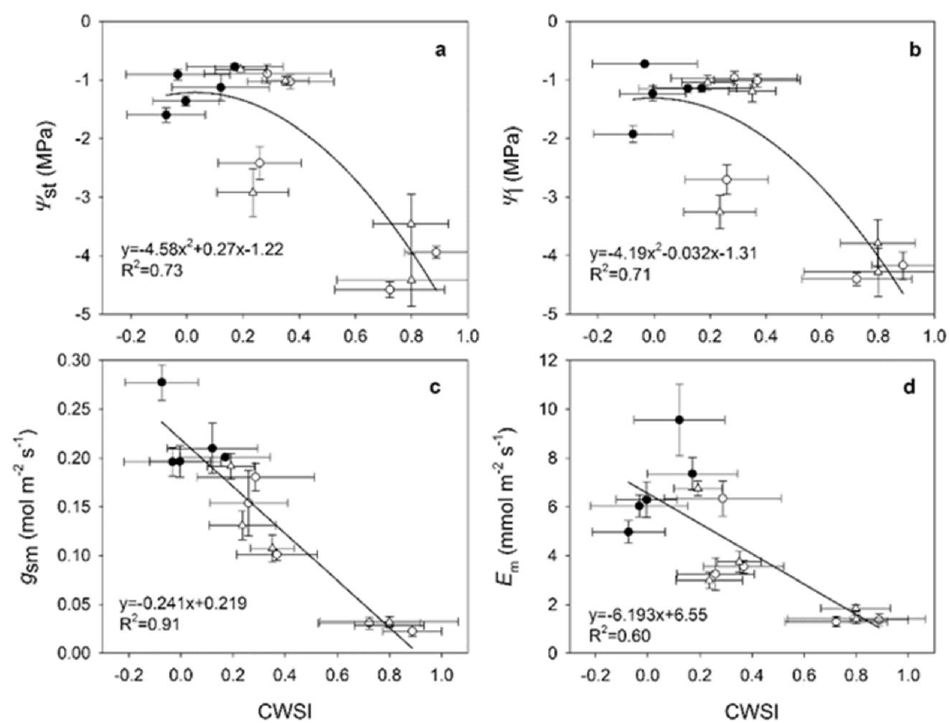
Figure 2. Relationship between CWSI determined from aerial thermal imaging and ( a ) midday stem water potential ( Ψ st), ( b ) midday leaf water potential ( Ψ l), ( c ) stomatal conductance (gsm), and ( d ) leaf transpiration rate (Em) for FI, 45RDICC, and 45RDITP treatments. The straight lines represent the fitted regression lines to the data. Data from